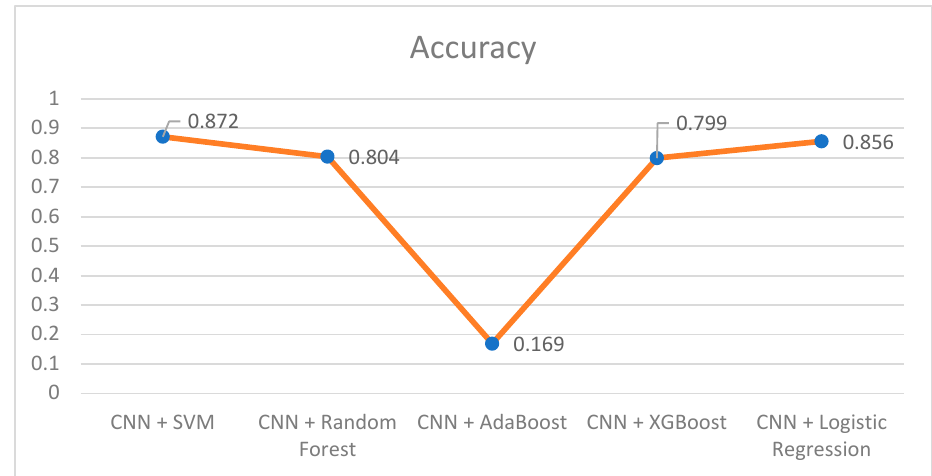
Figure 10. The accuracy of the hybrid models trained on the Arabic character